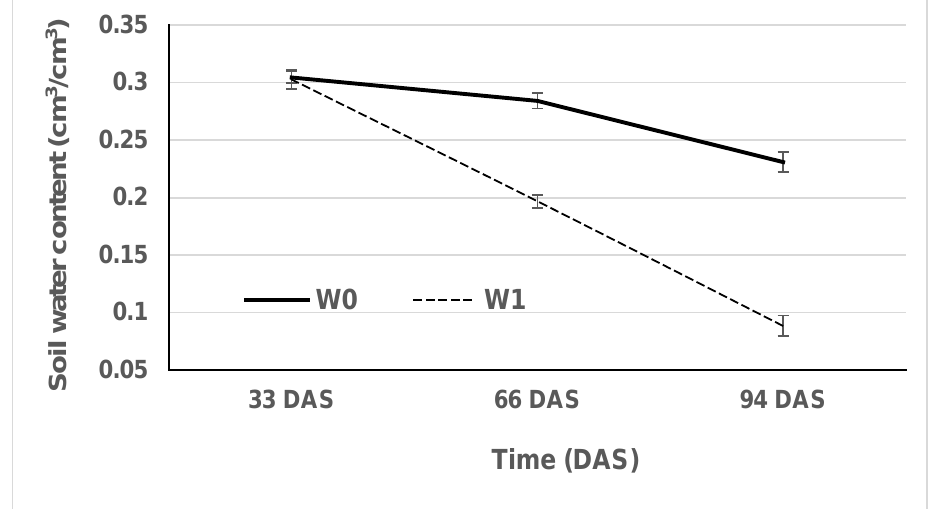
Figure 2. Average volumetric soil water content (cm 3 /cm 3 ) at 28 days after sowing (DAS) ( p = 0.007), 42 DAS ( p = 0.007), 56 DAS ( p < 0.001), and 70 DAS ( p = 0.042) at the Vermase site in 2018. W0, well- watered control; W1, water withheld from flower initiation to maturity; W2, water withheld after 61.6%, respectively, relative to the well-watered control (W0). seedling establishment to maturity. Bars indicate the standard error of means.